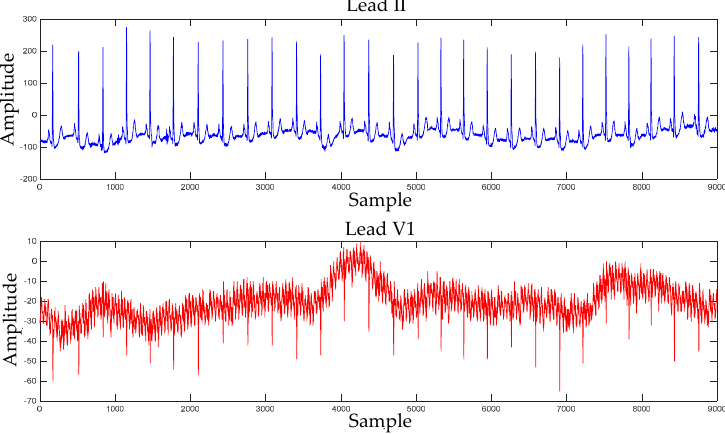
Figure 4. The comparison of DL-CCANet, PCANet, and RandNet on the MIT-BIH database.